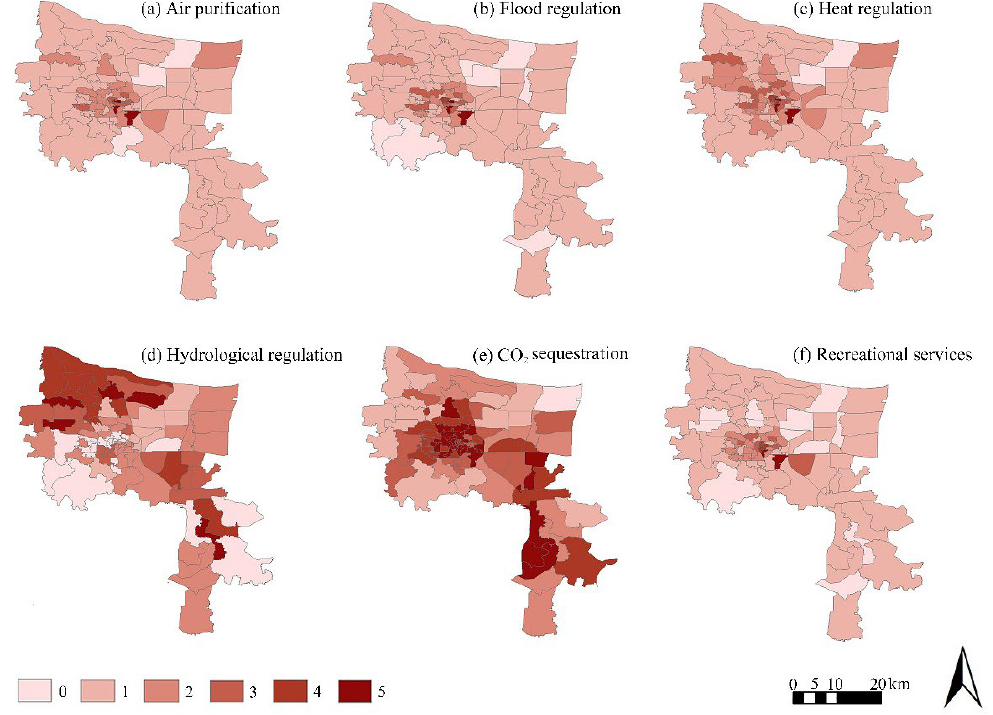
Figure 2. The results of excessive demand evaluation for each urban ecosystem service.